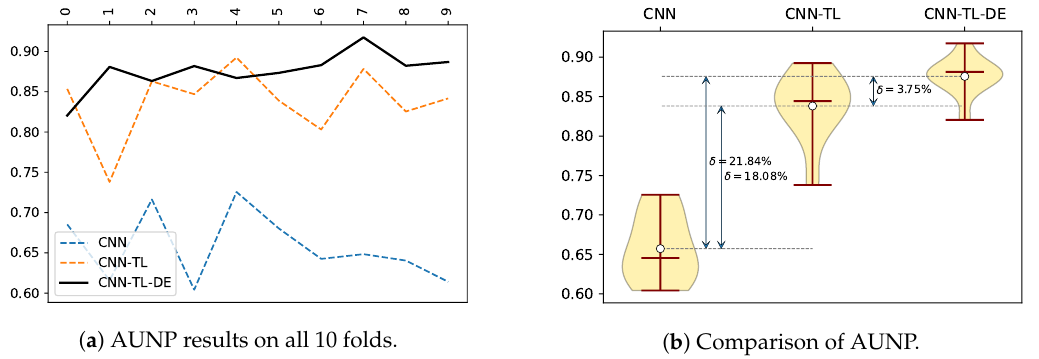
Figure 4. Comparison of AUNP results for the compared methods over 10 folds.